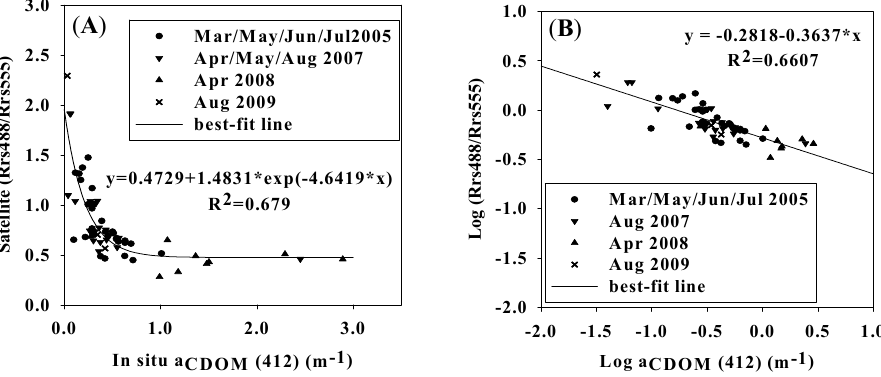
band ratio (488 nm and 555 nm) plotted against in situ Figure 7. MODIS-derived R rs surface CDOM absorption at 412 nm ( A ) exponential decay model and ( B ) logarithmic model.